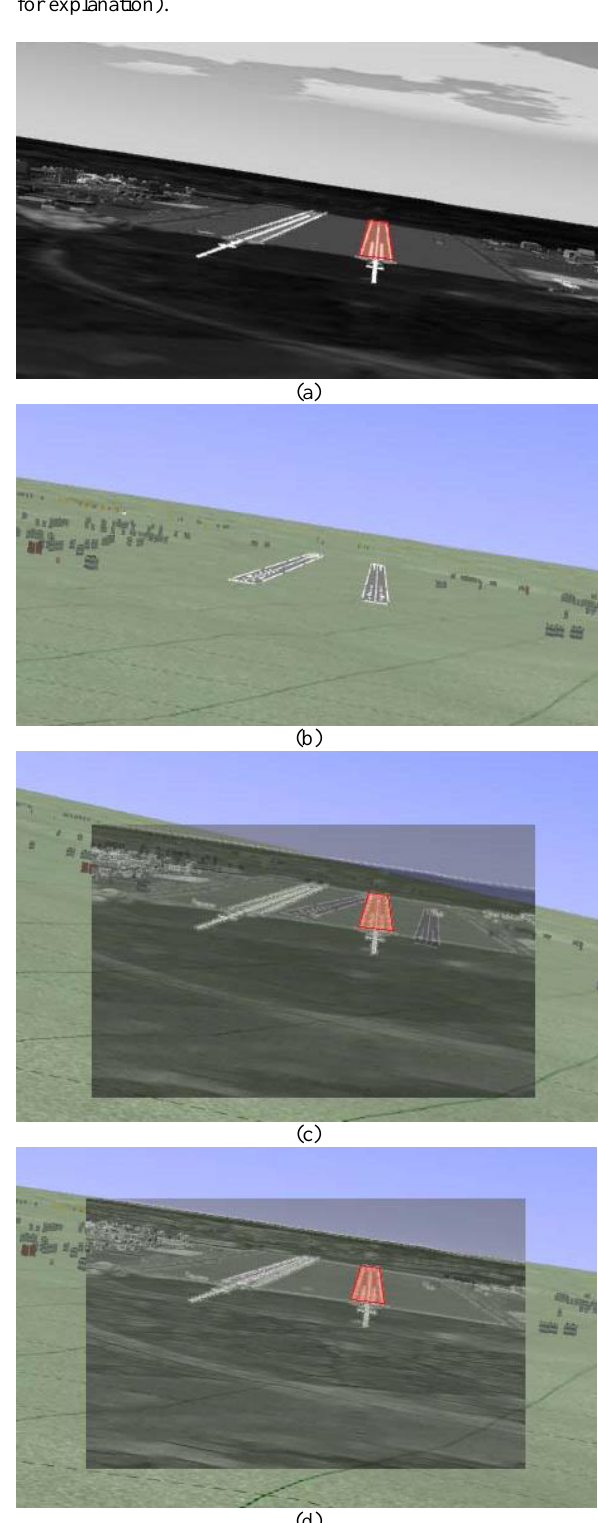
Figure 5. Testing of the algorithm by means of computer simulation: a) modeled TV image (fragment) and the result of the runway detection; b) SVS